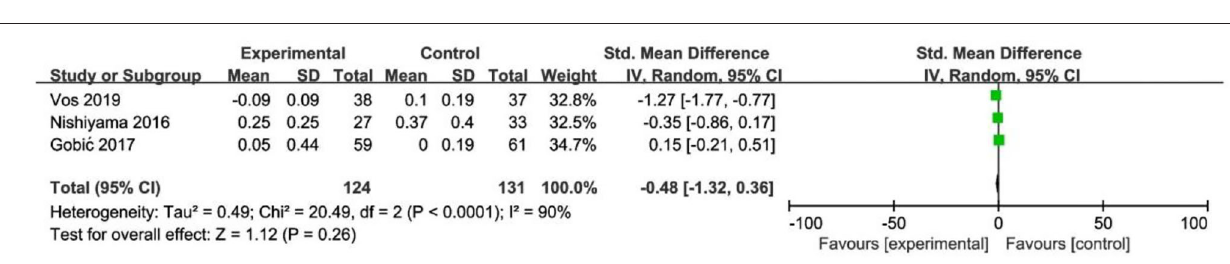
FIGURE 6 | Meta-analysis of the effects of DCB compared with control in TLR.